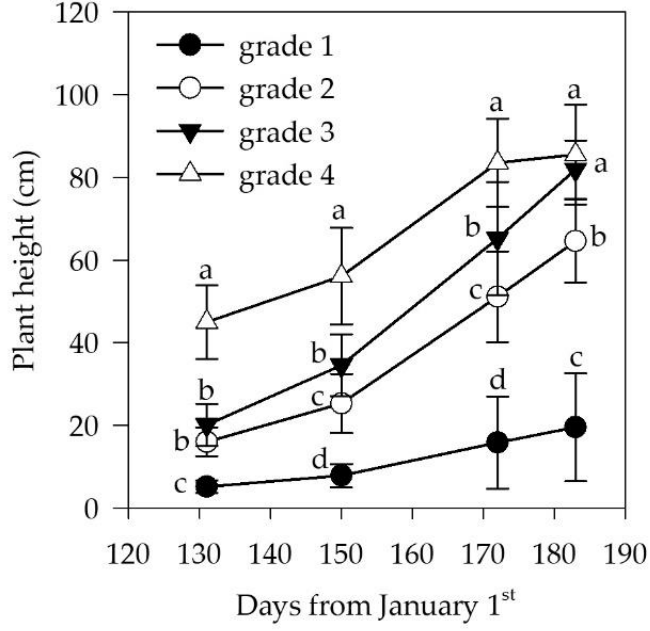
Figure 3. Plant heights of the four grades of tall wheatgrass seedlings grown in different saline- alkaline soils. Data were represented as mean ± SD. Different letters indicate a significant difference at p < 0.05.